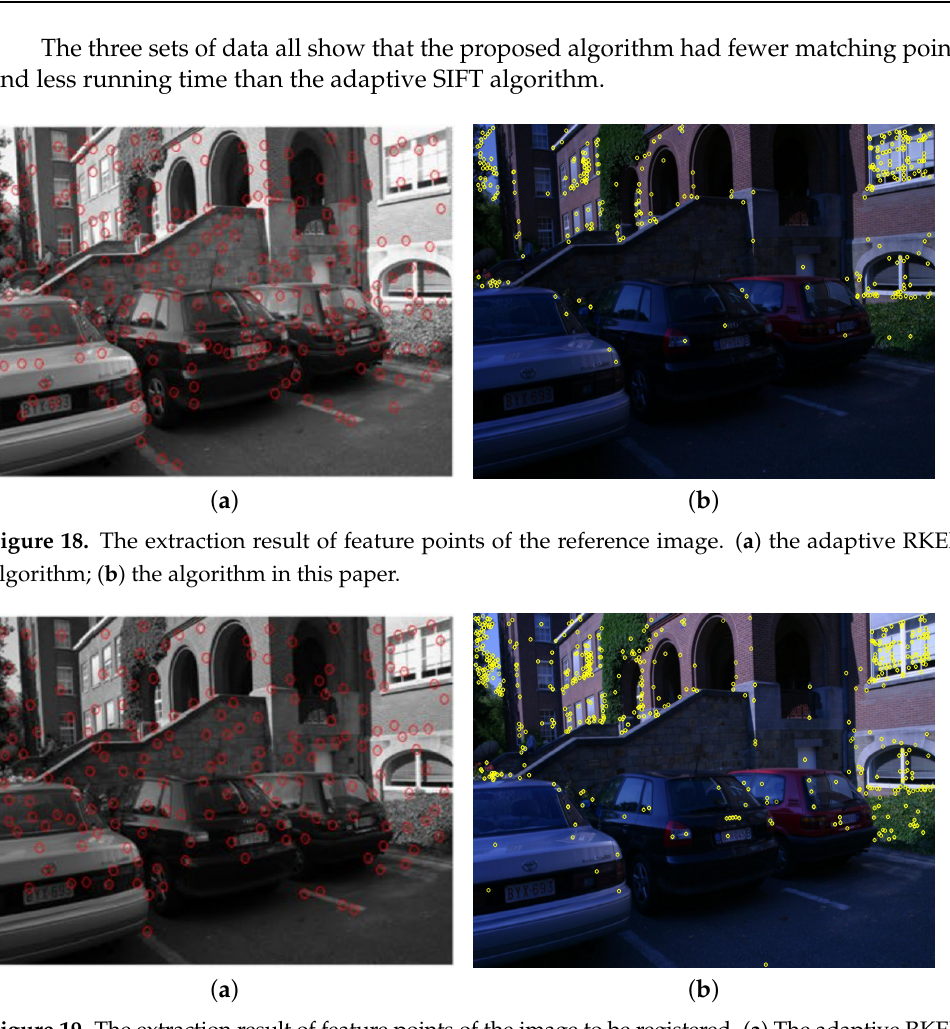
Figure 19. The extraction result of feature points of the image to be registered. ( a ) The adaptive RKEM algorithm; ( b ) The algorithm in this